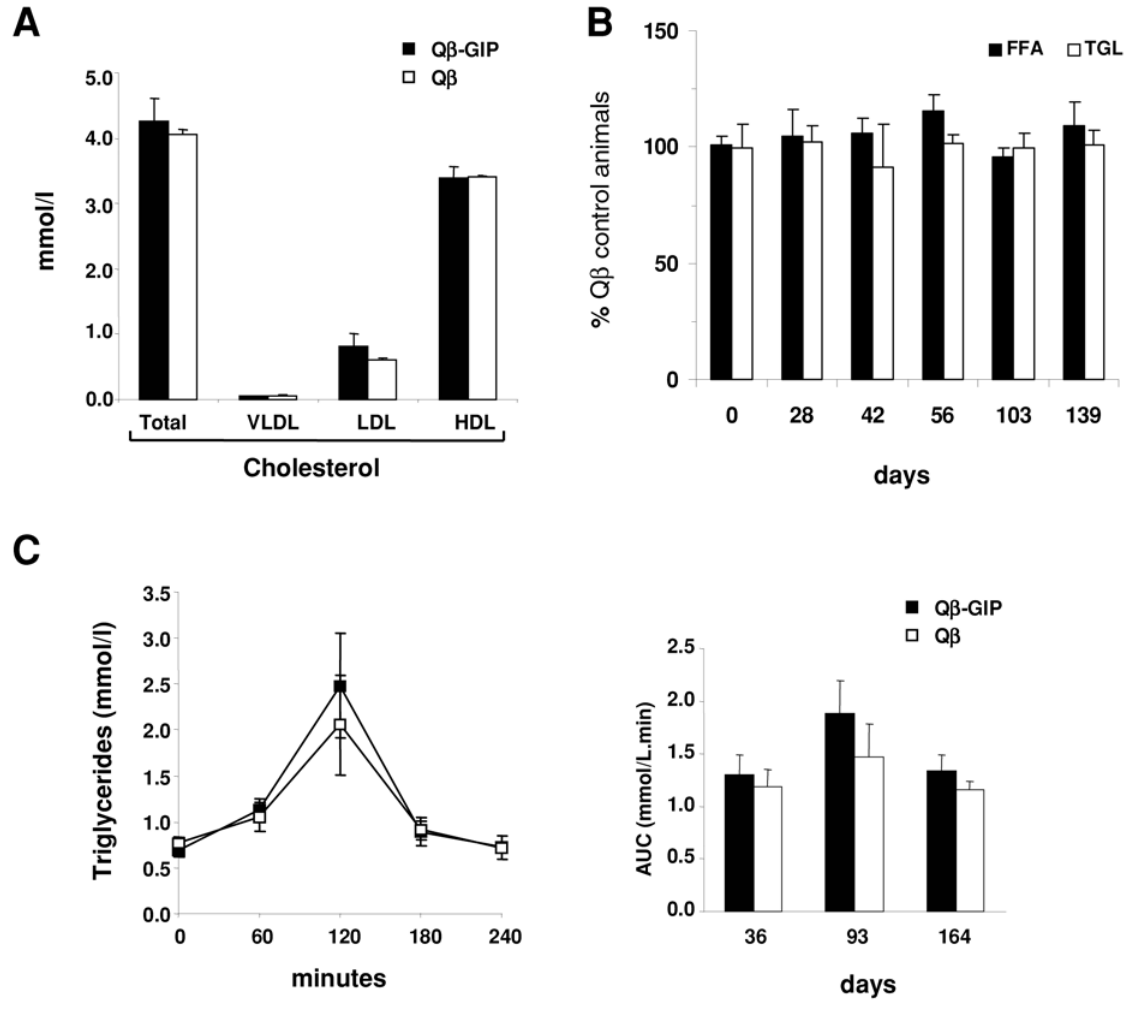
Figure 5. Vaccination against GIP does not alter lipid metabolism. (A–C) Female mice were immunized (days 0, 14, 28, 42) with Q b -GIP or Q b VLPs and placed on a high fat diet. (A) Serum lipid profile in mice on day 122. Total, vLDL, LDL and HDL cholesterol was measured. Average values 6 SEM (n=10) are shown. No significant differences were observed between the groups (p . 0.05). (B) Serum TGL and FFA profiles in mice. The percentage of control animals immunized with Q b VLPs 6 SEM (n=5) at the indicated time point are shown for triglycerides and free fatty acids. No significant differences in TGL or FFA levels were observed between the groups (p . 0.05). (C) Postprandial lipid clearance in mice. Female mice were immunized (days 0, 14, 28, 41 and 126) with Q b -GIP or Q b VLPs and placed on a high fat diet. OLTT were performed at the indicated time points. The left panel shows the OLTT performed on day 36. AUC for all investigated time points is shown on the right. Average triglyceride levels or AUC 6 SEM (n=5) are shown for each group. No significant differences were observed between the groups (p . 0.05). All statistical analyses were performed by two sided t-tests.